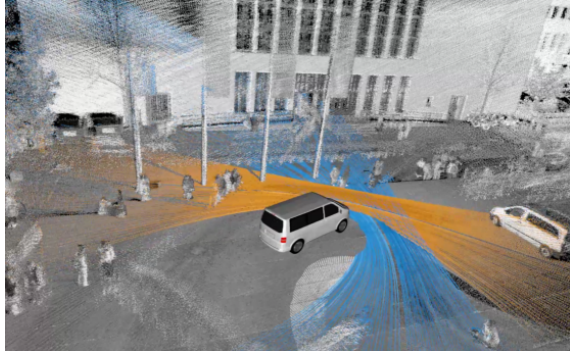
Figure 5. Two oblique mounted laser scanners of the MLS system. Figure courtesy of (Gehrrng et al.,